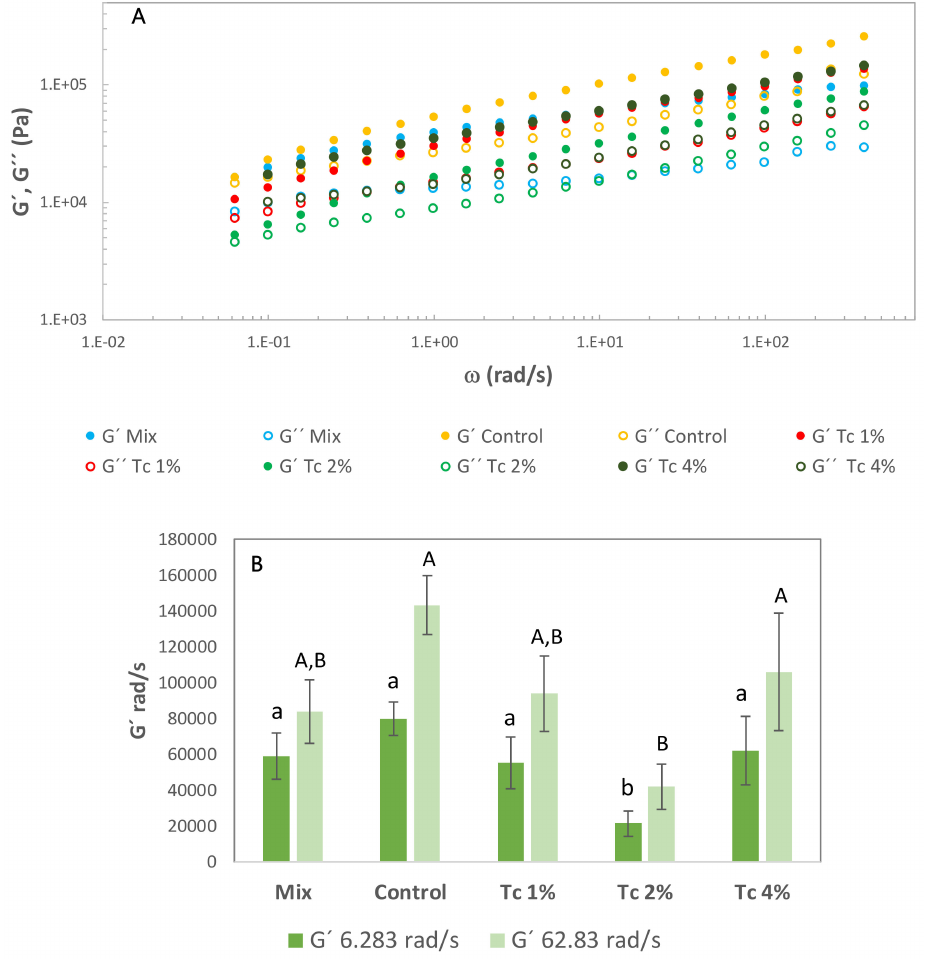
Figure 2. ( A ) Mechanical spectra and ( B ) values of G’ at 6.283 rad / s (1 Hz) and 62.83 rad / s (10 Hz) obtained after GF dough fermentation. G’ (storage modulus—filled symbol), G” (loss modulus—open symbol). Mix, Control and GF dough with T. chuii Tc 1%, Tc 2% and Tc 4%. Error bars indicate the standard deviations from the repetitions. Di ff erent letters correspond to significant di ff erences ( p <